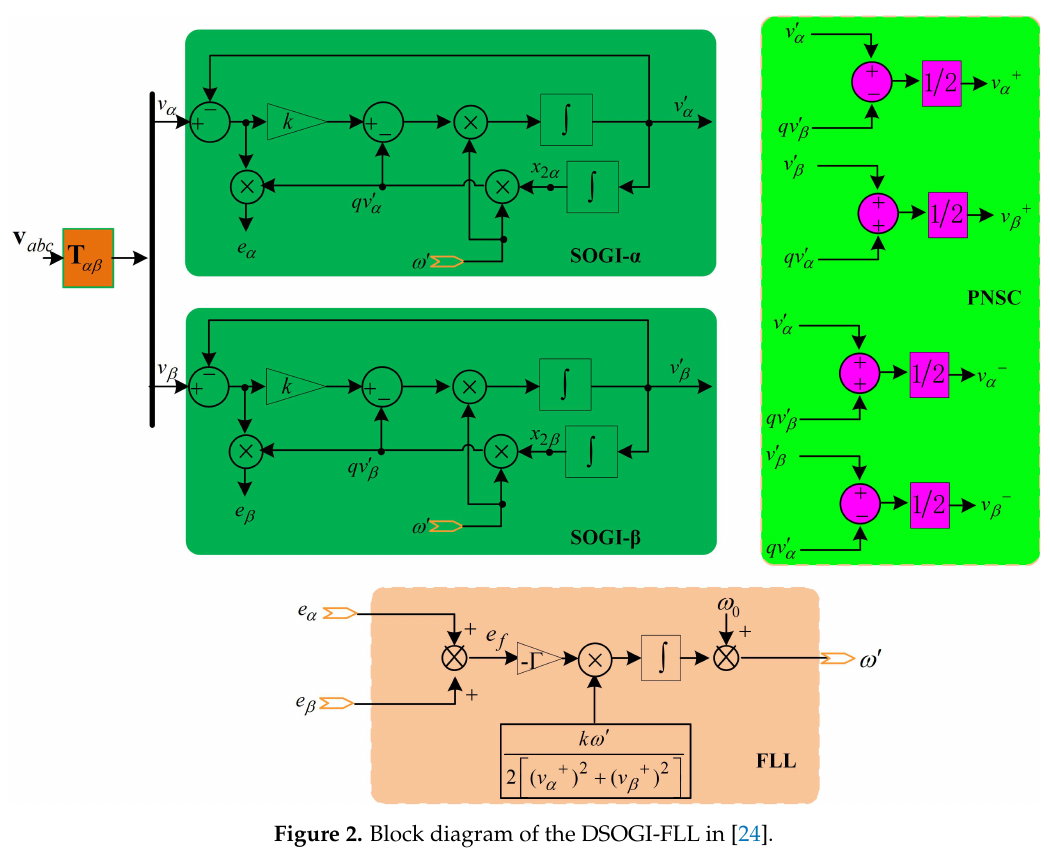
Figure 2. Block diagram of the DSOGI-FLL in [24].